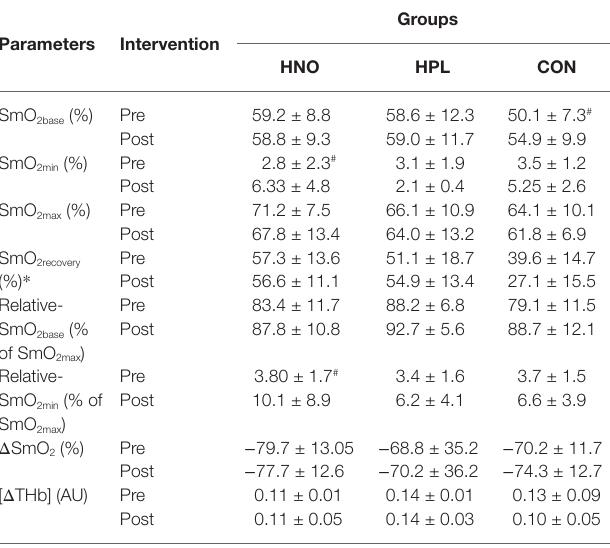
TABLE 2 | Mean ± SD values for the oxygen saturation’ parameters obtained during the T lim for high-intensity exercise training sessions performed in hypoxia with NO 3 − (HNO), in hypoxia with placebo (HPL), and in normoxia with placebo (CON). Parameters